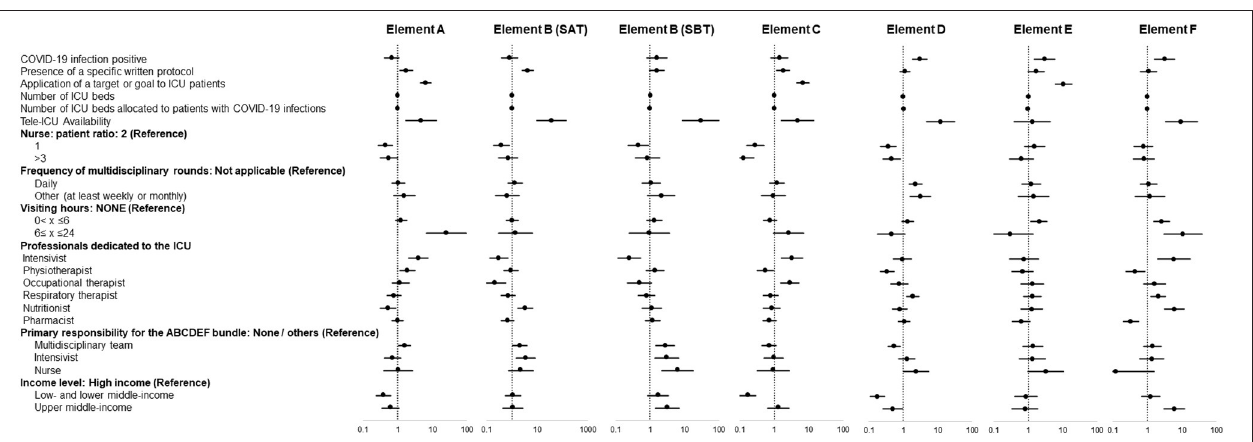
Frontiers in Medicine |